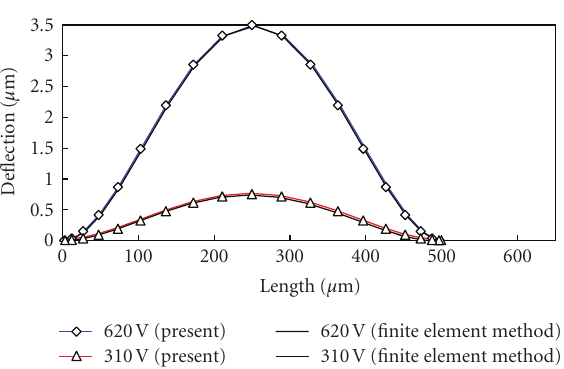
Figure 2: Deflections of an electrostatic fixed-fixed actuator for various applied voltages.